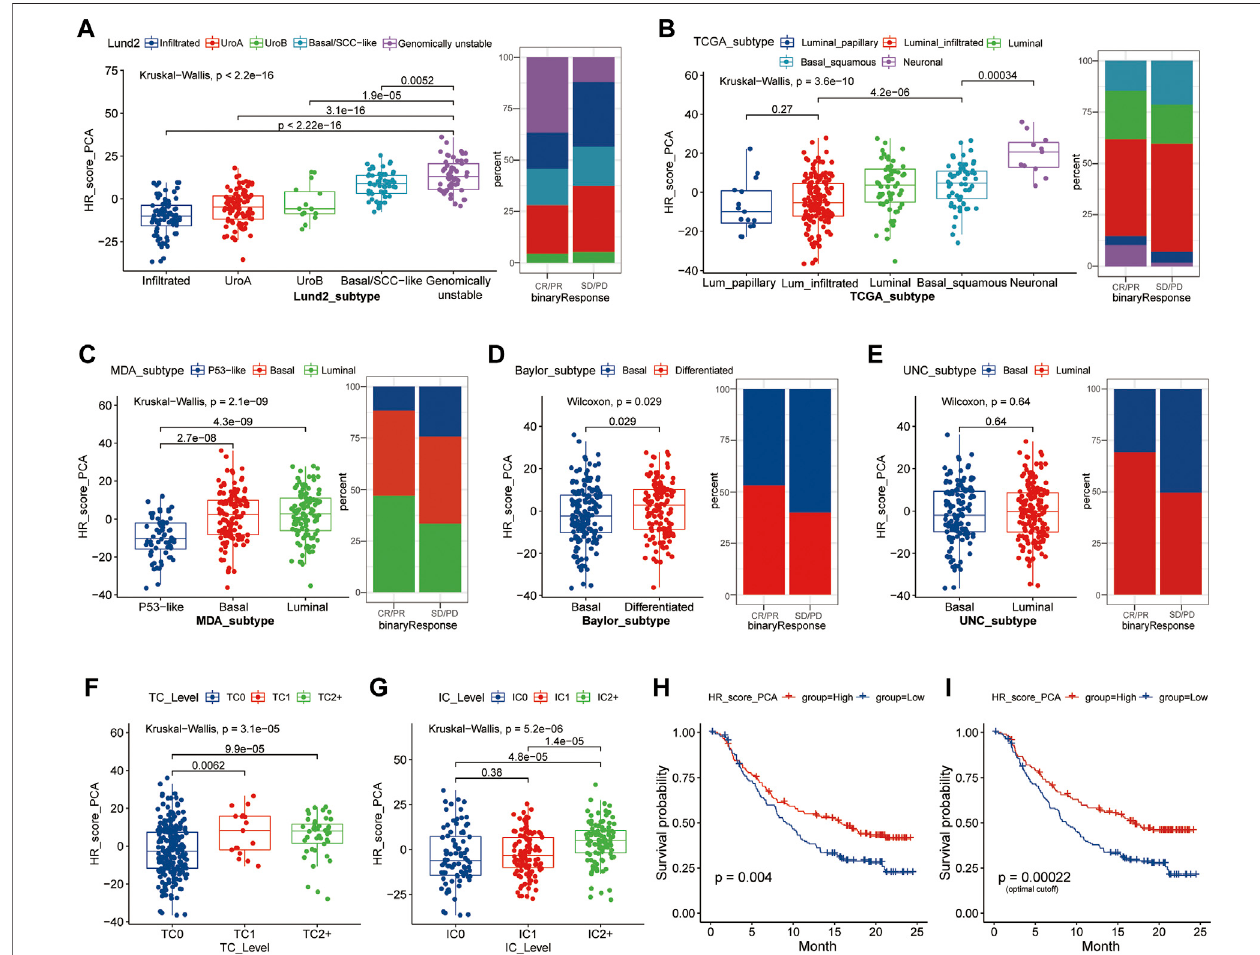
FIGURE 4 | HR score distribution in different subtypes of samples based on different molecular features. (A – E) , The distribution of HR scores in different subtypes wasbasedonLund2, TCGA,MDA, Baylor,and UNCclassi fi cations methods, aswell asthecompositionratioofdifferentsubtypes intheCR/SPand SD/PDgroups; (F, G) , The distribution difference of HR score in different tumor level and immune level; (H,I) , Kaplan-Meier survival analysis was performed on patients in the high and low groups according to the median HR expression value (H) or optimal HR cut-off value (I) . Lund, Lund University; TCGA, The Cancer Genome Atlas; MDA, MD Anderson Cancer Center, UNC, University of North Carolina; HR, homologous recombination; TC, tumor cells; IC, immune cells; CR/PR, complete response/partial response; SD/PD, stable disease/progressive disease.